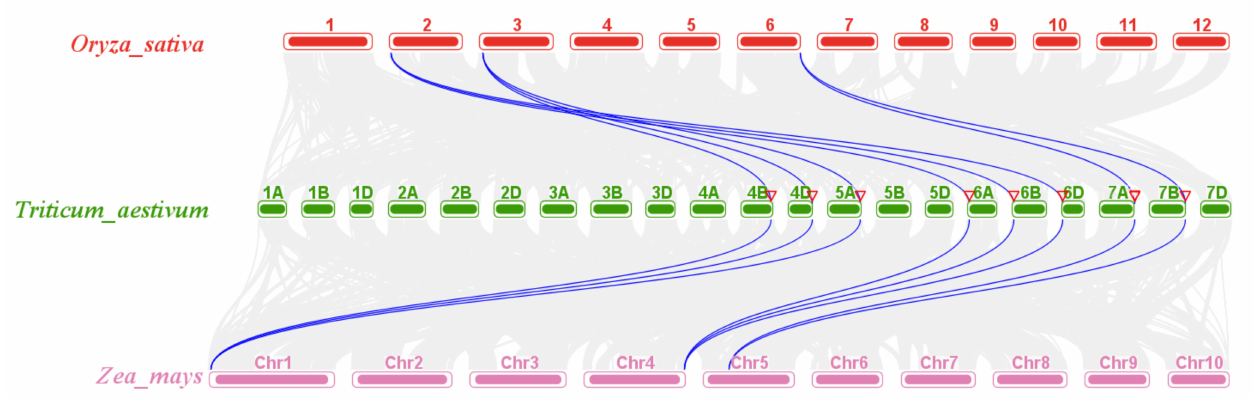
Figure 4. Synteny analysis of CAT genes between wheat, rice, and maize. Gray lines indicated all collinearity blocks within wheat and other plant genomes, and the duplicated CAT gene pairs were highlighted by blue lines. The positions of TaCATs were indicated with red